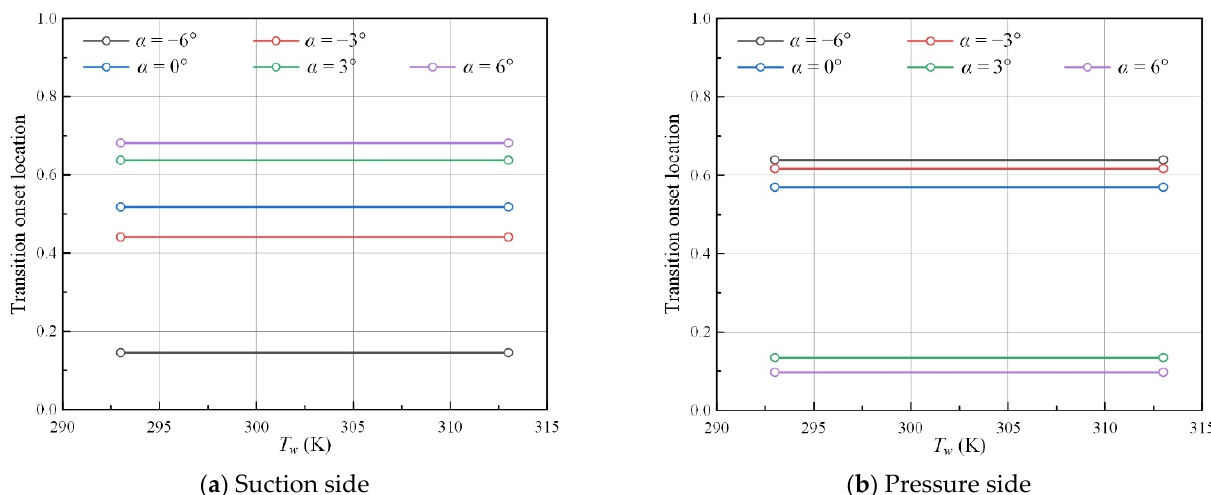
Figure 8. Transition onset locations under various surface temperatures ( ε = 0.5%, Ma = 0.4).